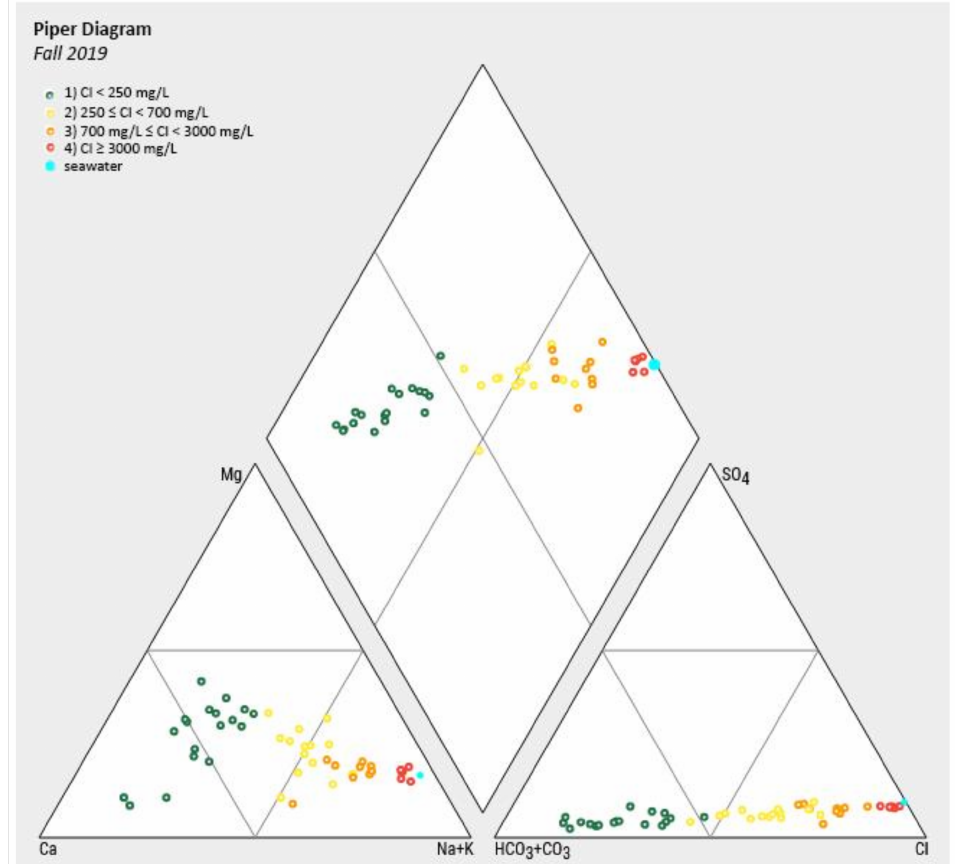
Figure 2. Piper diagram showing major groundwater components of Coastal Murgia in autumn